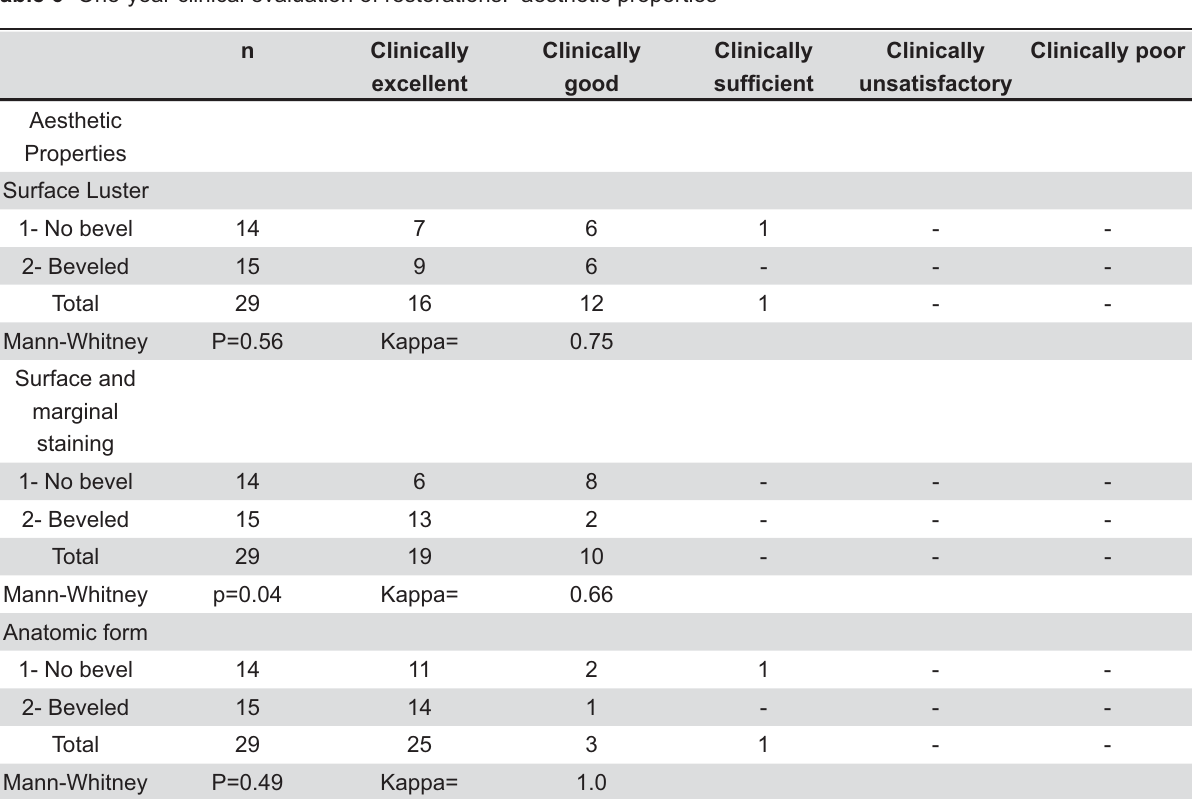
Table 6- One-year clinical evaluation of restorations: aesthetic